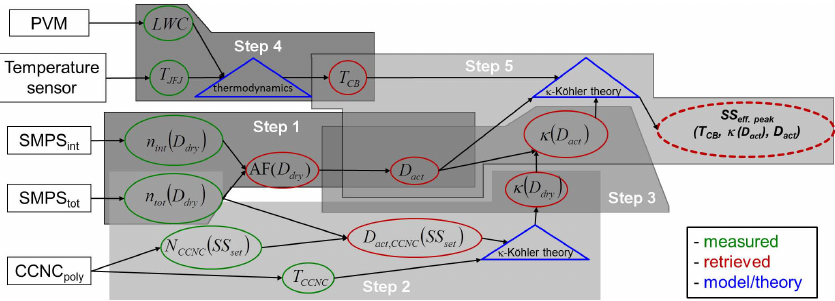
Fig. 2. Procedure illustrating how the effective peak supersaturation is retrieved. In rectangles the instruments used are depicted, in circles the measured and calculated parameters are shown and the triangles represent theoretical calculations. The “thermodynamic” triangle is the theory explained in Sect. 3.3, Step 4. LWC is the liquid water content, T JFJ is the temperature measured at the JFJ, T CB is the temperature at the cloud base, n int (D dry ) is the interstitial aerosol size distribution, n tot (D dry ) is the total aerosol size distribution and N CCNC ( SS set ) is the number concentration of CCNs per SS. AF( D dry ) is the activated fraction as a function of dry diameter retrieved from the SMPS measurements. D act is the activation diameter estimated from the SMPS measurements and D act,CCNC ( SS set ) is the ambient activation diameter estimated from the combining of the SMPS and CCNC measurements per SS at the temperature of activation in the CCNC. κ(D dry ) is the hygroscopicity parameter as function of the particle diameter estimated from the CCNC measurements and κ(D act ) is the hygroscopicity parameter estimated for the ambient conditions at the ambient activation diameter.